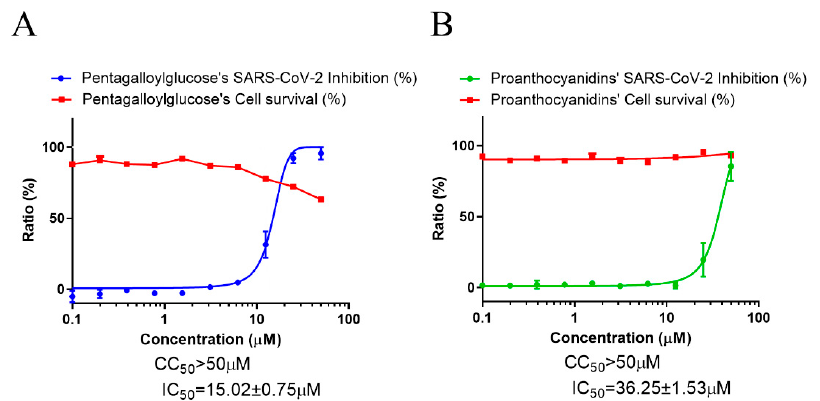
Figure 2. Anti-SARS-CoV-2 activity of PGG and PAC. ( A ) The dose–response curve analysis by the immunofluorescence-based antiviral assays showed the antiviral effect of PGG ( A ) and PAC ( B ) in SARS-CoV-2 infected Vero cells. Blue circles ( A ) and green circles ( B ) indicate the inhibition percentage of the SARS-CoV-2 infection by PGG and PAC, respectively, in a dose-dependent manner, and red squares indicate cell viability (%). The data represent duplicate experiments, and are presented as the mean ± SEM.